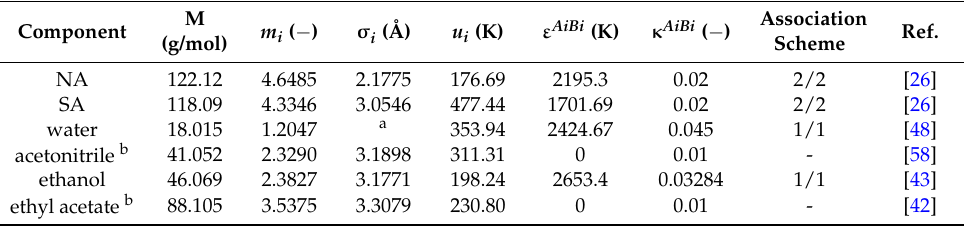
Table 3. PC-SAFT pure-component parameters for nicotinamide (NA) succinic acid (SA), and (anti-)solvents considered in this work.